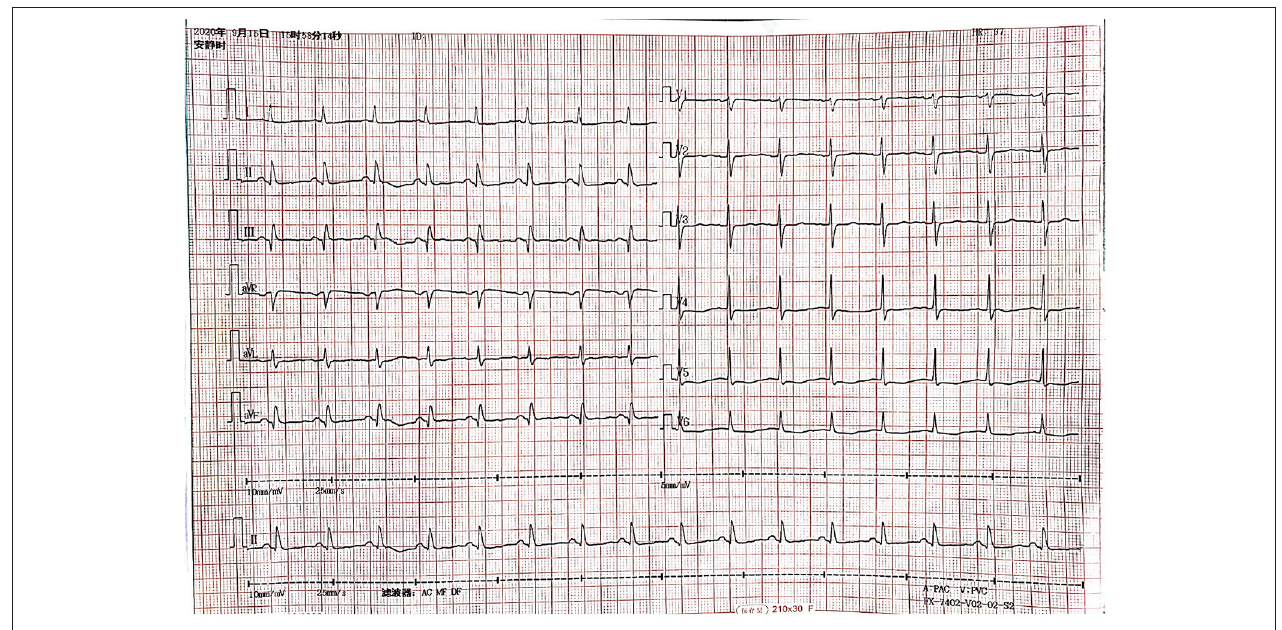
FIGURE 1 | Electrocardiogram after admission to our